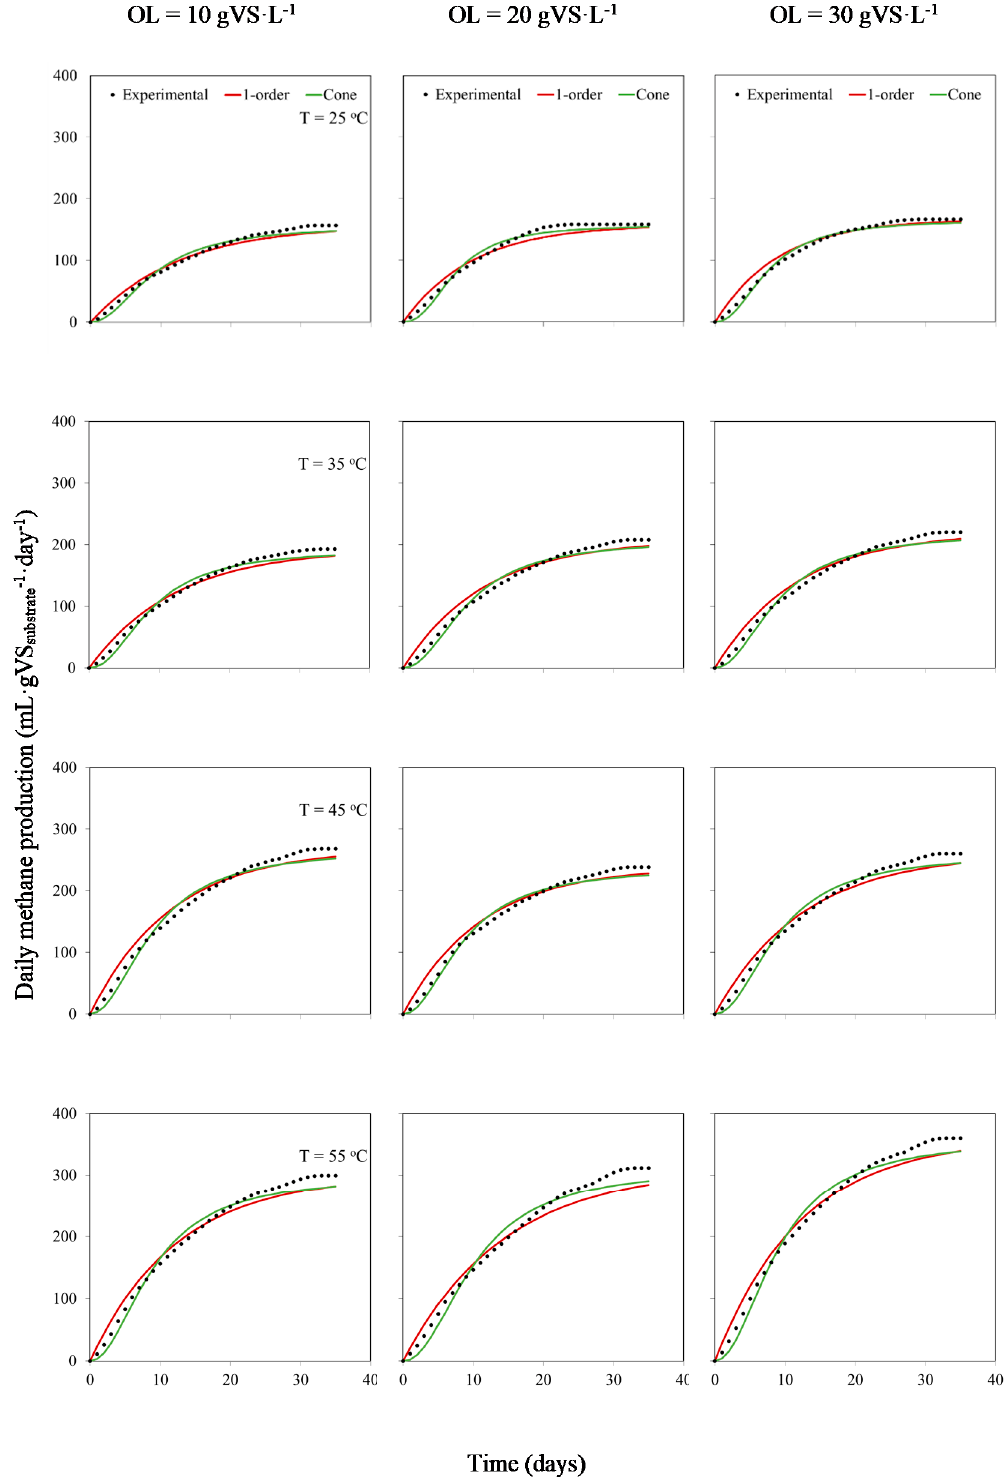
Figure 5. Plot of measured and predicted methane yields for all the reactors. ◦ − 1 R8 at 45 C with 20 g VS L showed the highest hydrolysis rate 0.1826 (R2 = 0.9651) using the ◦ − 1 first-order model. In the cone model, treatments (R2 and R3) at 25 C with 20 and 30 g VS L showed the highest hydrolysis rates 0.1356 (R 2 = 0.9775) and 0.1329 (R 2 = 0.9857), respectively. However, the di ff erence with the other reactors is not significant, indicating that there is no clear